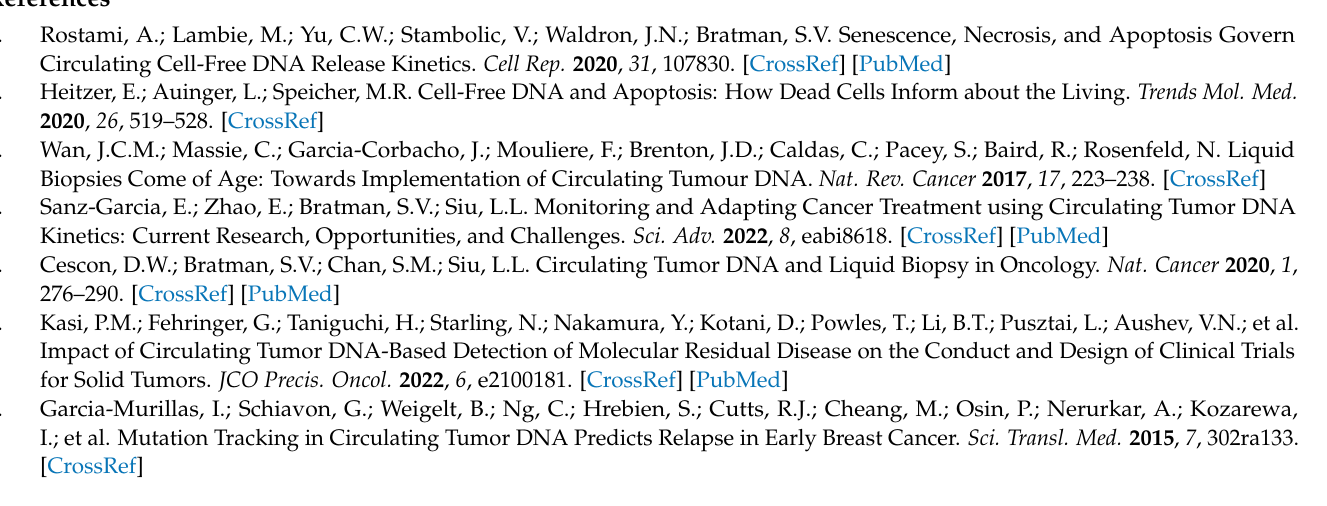
Figure S1: Current measurements using only DNA-intercalating methylene blue (MB) or dual DNA- intercalating MB/iron oxide nanozymes bioelectrocatalytic cycling; Figure S2: Optimization of isothermal amplification times; Figure S3: Optimization of electrolyte